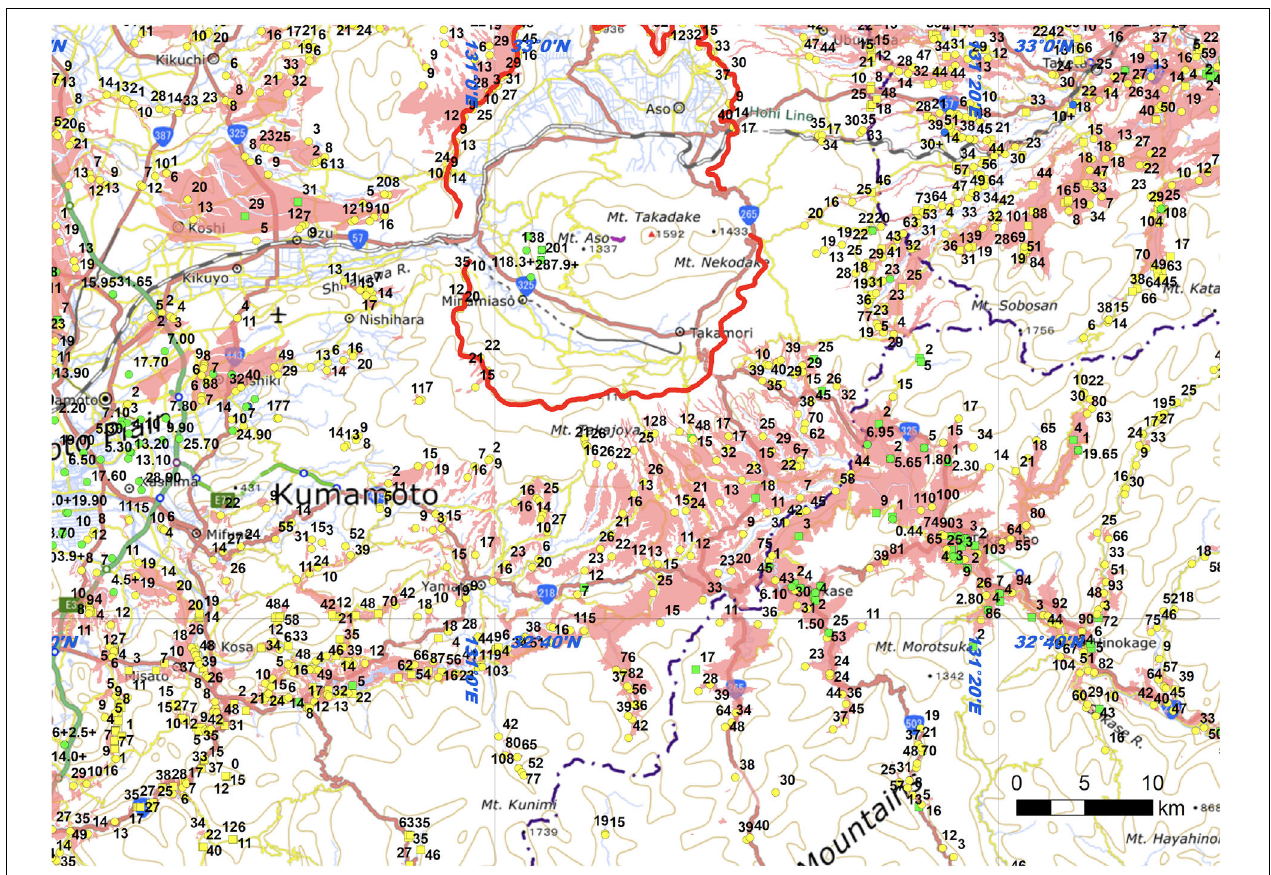
FIGURE 4 | Distribution of Aso-4 PDC deposits and thickness data. The thickness values of the deposits are shown in meters. Circles and squares on the map indicate locations to measure the thickness of PDC deposits based on outcrops (blue), borehole (green), and topography (yellow) sites. The circle marks are non-welded, and the square marks are welded points. The Geospatial Information Authority of Japan (GSI) Tile Map (English) is used as the base map.